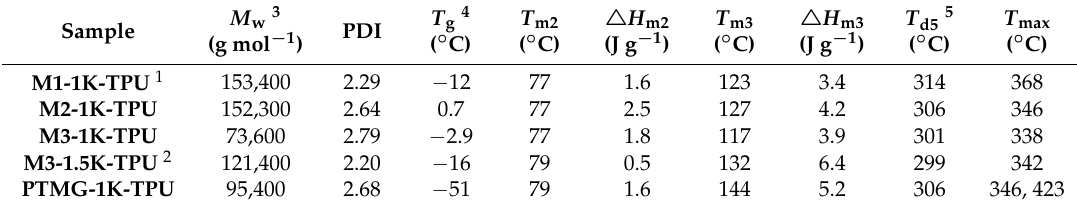
Table 2. Thermal characterizations of